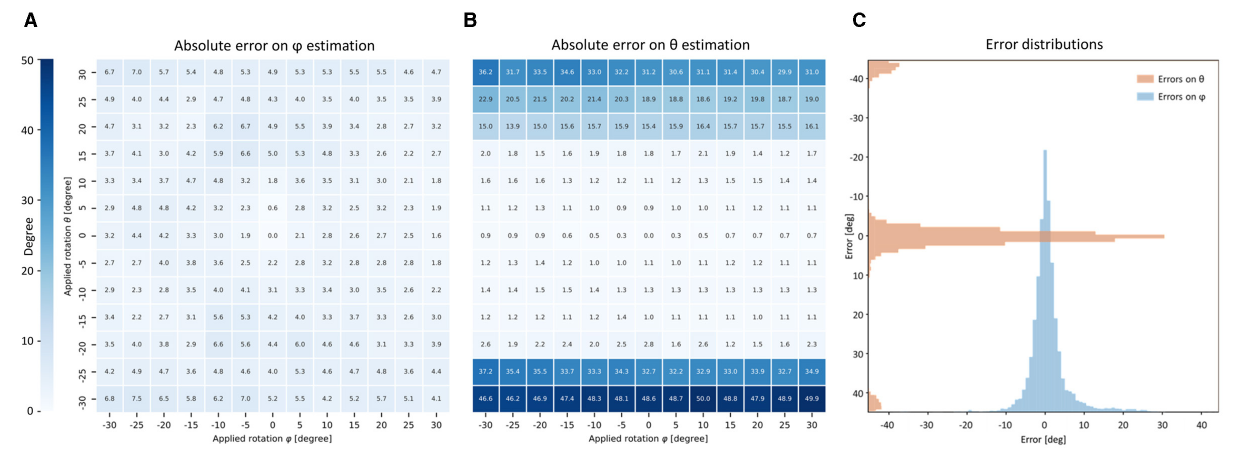
× 13 virtual rotations applied on ×